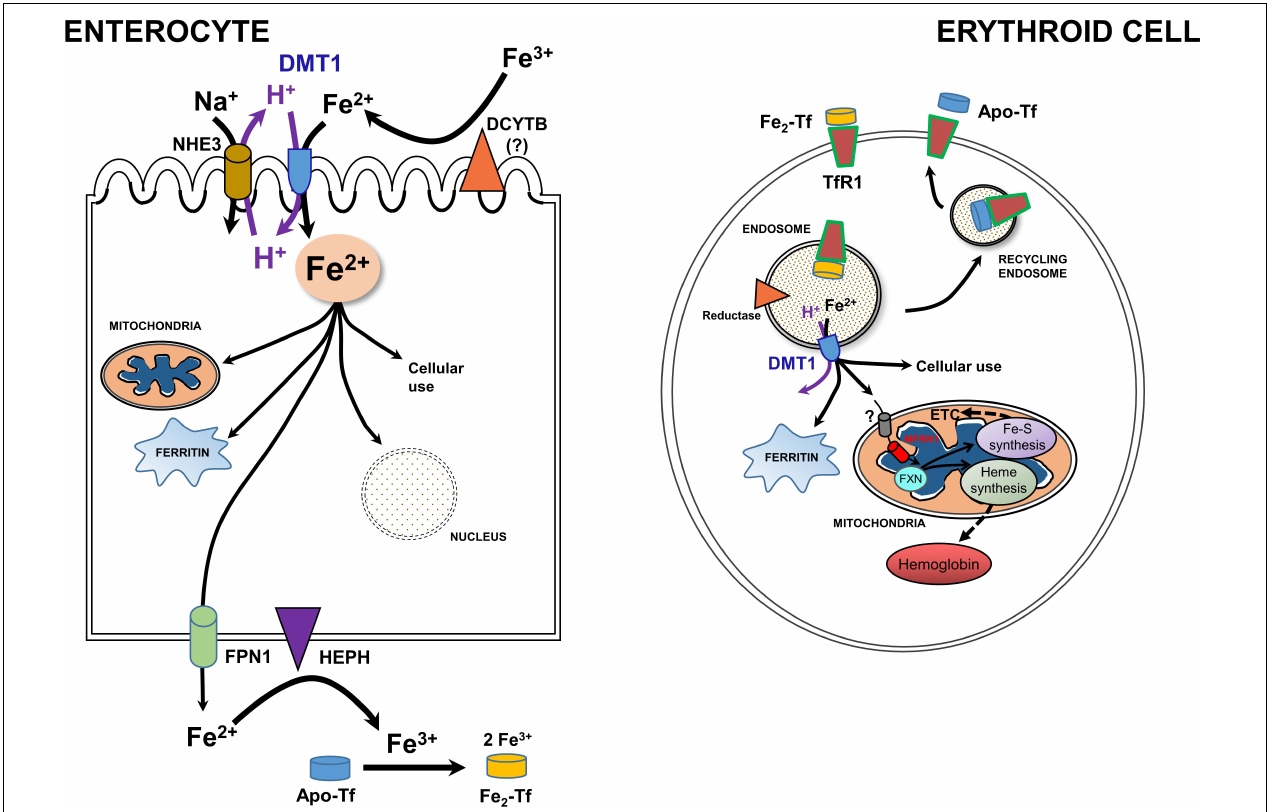
FIGURE 3 | A model for integration of cellular iron homeostasis with systemic iron homeostasis. Keys: Enterocytes, iron (Fe 3 + & Fe 2 + ), a ferrireductase (DCYTB); “?” indicates that it is unlikely to be the only reductase), DMT1, NHE3, a mitochondrion, ferritin, the nucleus, Hephaestin (HEPH), Ferroportin (FPN1) and Na + /K + antiporter. Not shown are tight junctions with other enterocytes and the Tf-receptor that likely binds apo-Tf so that it can be loaded with Fe. Also keyed: Erythroid cells, TfR1. di-ferric Tf binding to TfR1, apo-Tf released by it, endocytosis -making an endosome to go through the Tf-cycle (see text), an endosomal reductase, an ATPase, DMT1, cytosolic ferritin, mitochondrial components, and metabolism including Mfrn1 = erythroid mitoferrin, FXN – frataxin, ETC and Fe-S plus Heme synthesis and hemoglobin formation. Adapted and redrawn from Wang et al. (2019) with permission from Oxford University Press on behalf of the American Society for